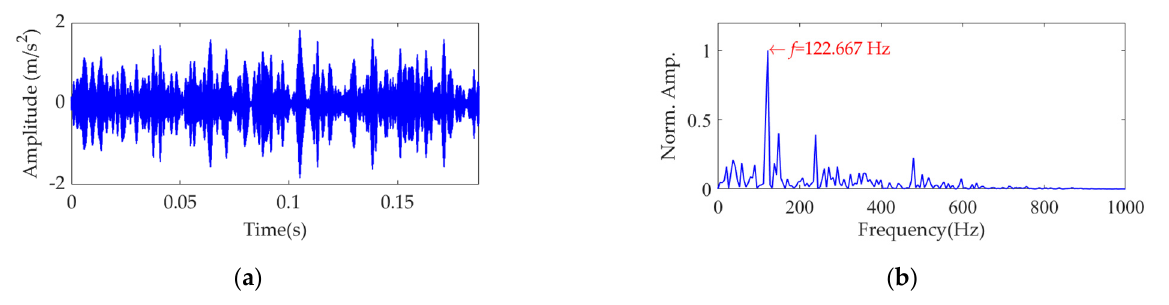
Figure 6. The EP index values of all modes.